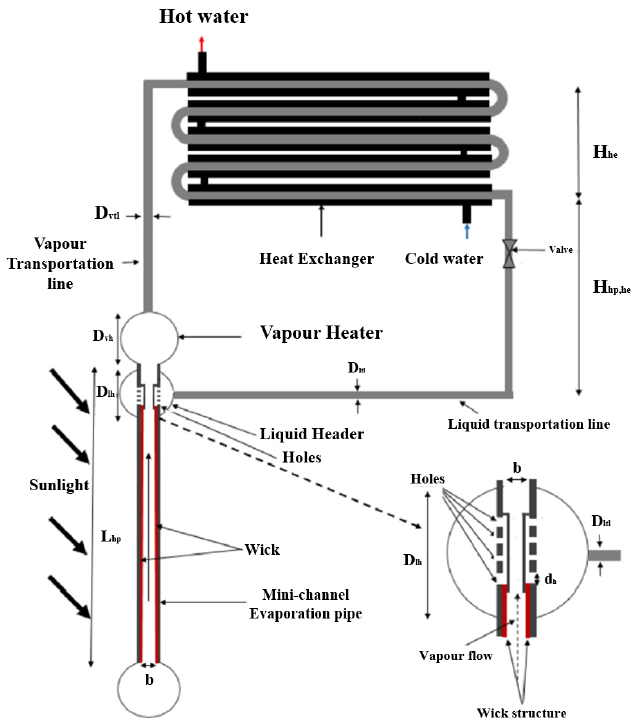
Figure 5. A schematic of a new design for the condensate liquid return path comprising the liquid transportation line and liquid upper feed header [86].